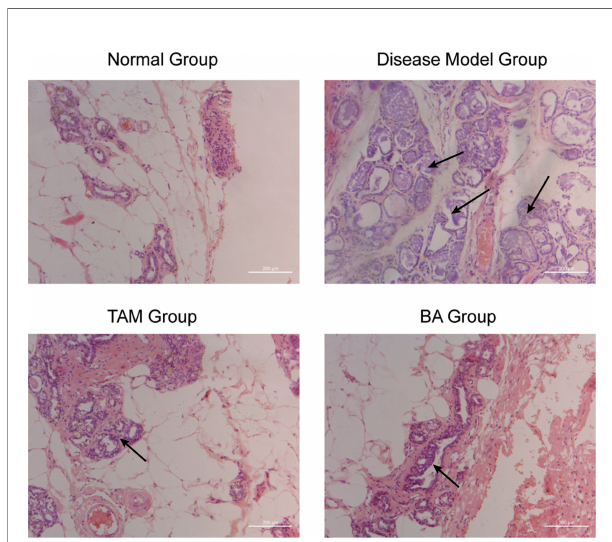
FIGURE 6 | b -BA could inhibit the breast precancerous lesions in vivo This panel shows the hematoxylin – eosin staining of the control group, the disease model group, the tamoxifen-treated group, and the b -BA-treated group, respectively.